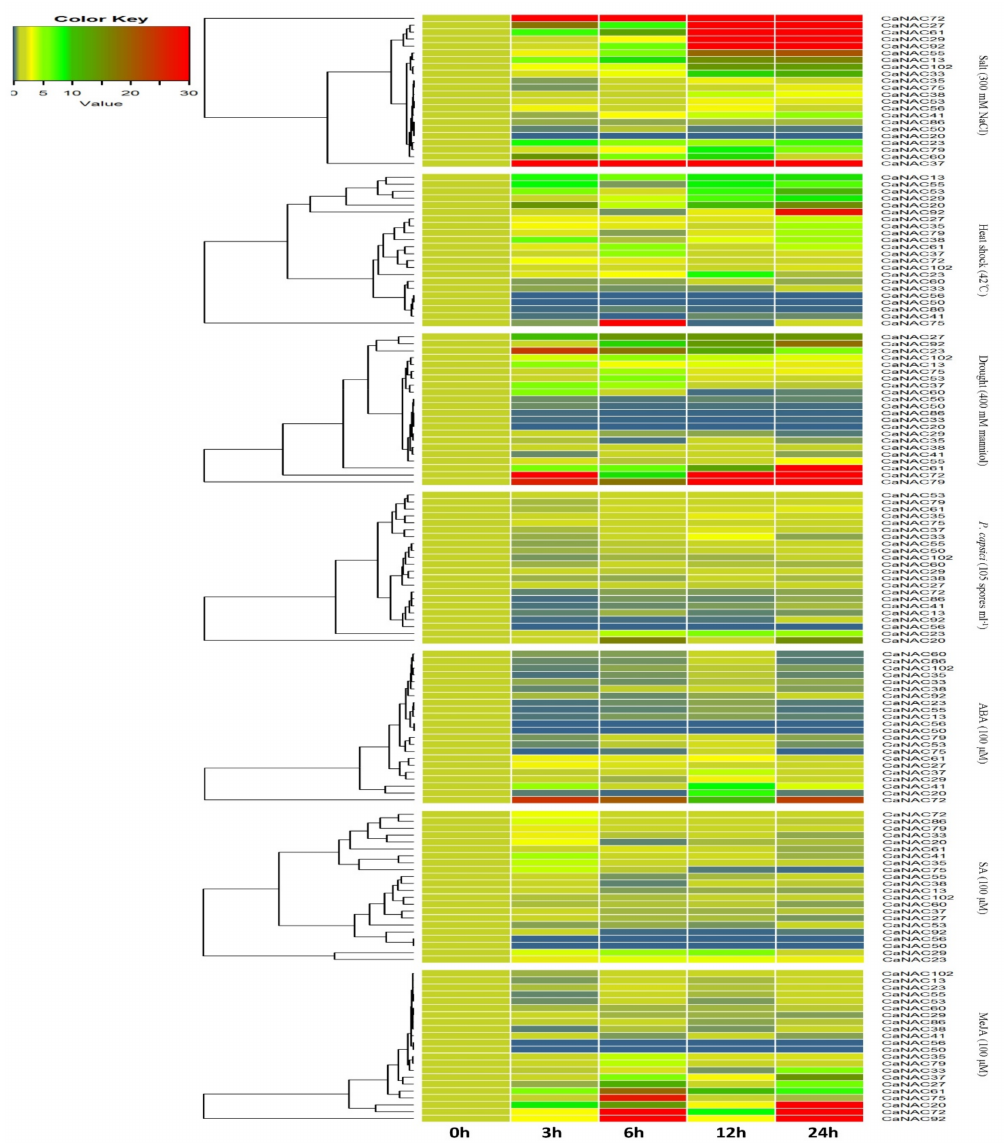
Figure 5. Heat map showing CaNAC genes expression pattern in pepper under seven different types of stress. The leaves or roots of the seedlings (six true leaves) were used to test the changes of CaNAC gene expression levels using real-time PCR at different timepoints (0, 3, 6, 12 and 24 h) with salt, heat shock, abscisic acid (ABA), salicylic acid (SA), methyl jasmonate (MeJA), drought, and Phytophthora capsici treatment, respectively. Actin 1 was used as an internal control. qRT-PCR data are shown relative to 0 h. The relative expression levels were calculated using the 2( − ∆ C t) method. The heat map was created using R